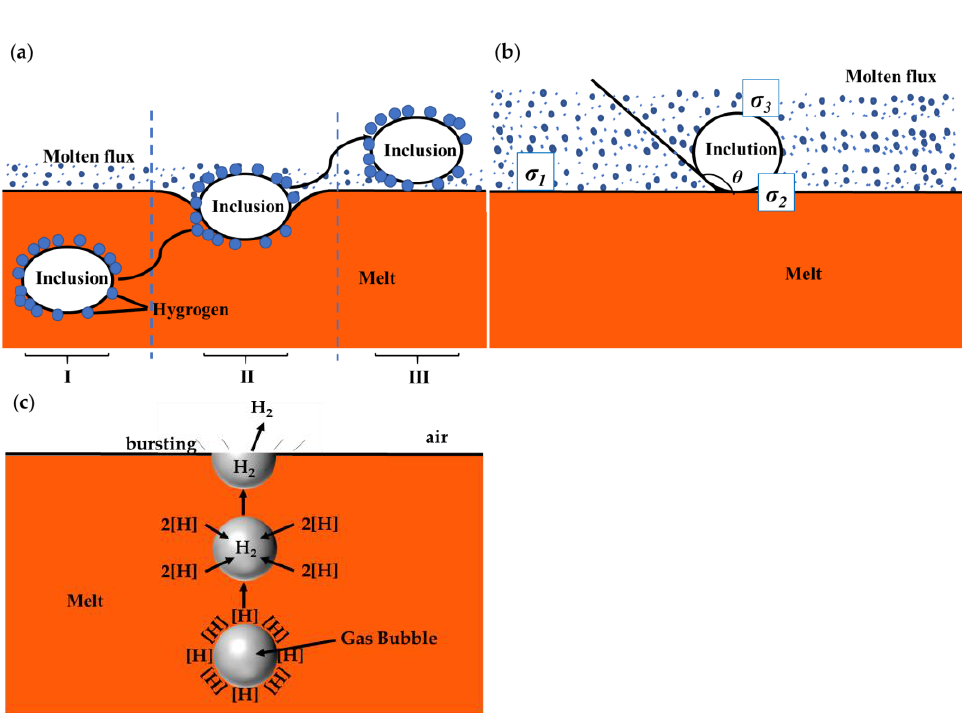
Figure 8. Schematic diagram of inclusions removal and degassing during flux treatment: ( a ) migration of inclusions from melt to flux. stage I: the inclusions approaching the melt – flux interface, stage II: inclusions crossing the aluminum melt – flux interface, stage III: inclusions transferring from the interface to the interior of the molten flux; ( b ) surface tension between inclusions and flux; ( c ) degassing through bubbles produced by the reaction between flux and oxide inclusion.